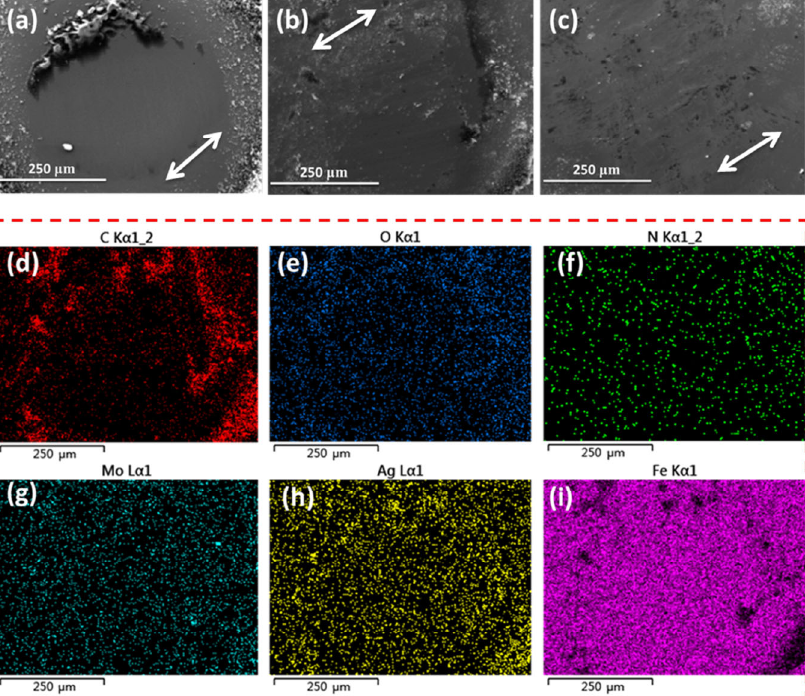
Fig. 6 SEM images of the tribofilms generated at different temperature (arrows is sliding direction): (a) RT, (b) 200 °C, (c) 350 °C, and EDS elemental maps of tribofilms at 200 °C (d) − (i).